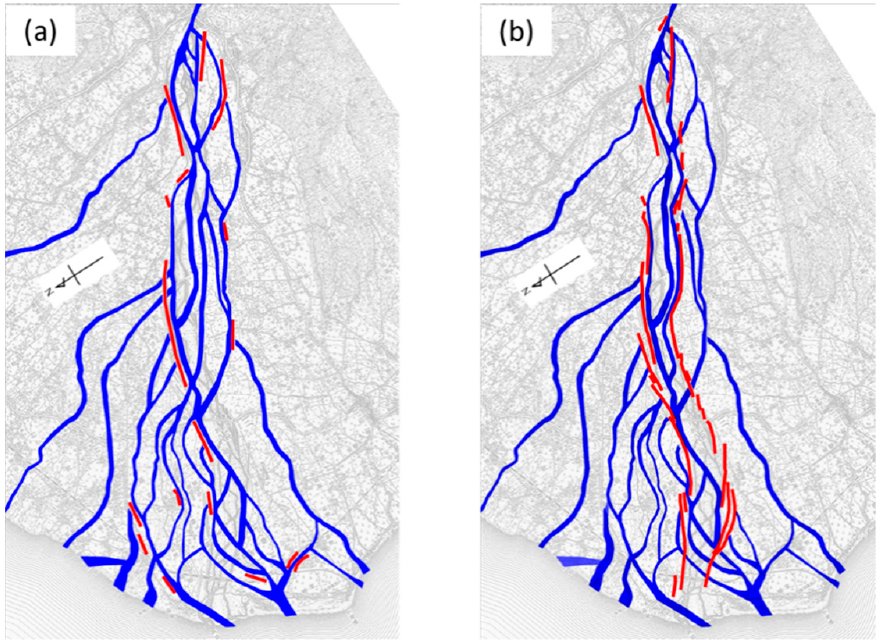
Figure 5. Mapping of the stream paths in 1785 (blue lines) to the map of 1910. ( a ) The red lines are levees in 1785. ( b ) The red lines are levees in 1894.